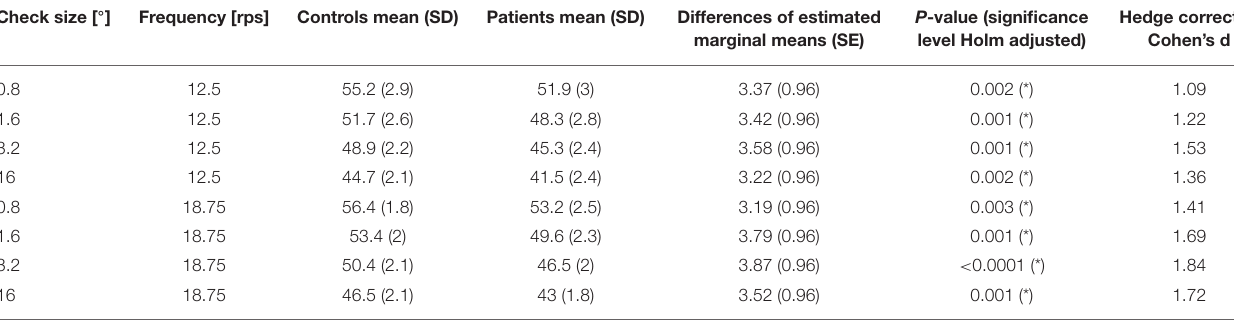
TABLE 4 | Results from the post-hoc analysis for calculated response times (in ms). Check size [ ◦ ]